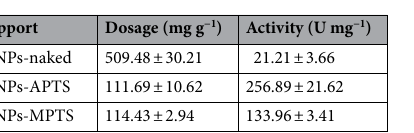
Figure 5. Quantification of conjugated enzymes ( A ), enzymatic activity of immobilized enzymes ( B ).